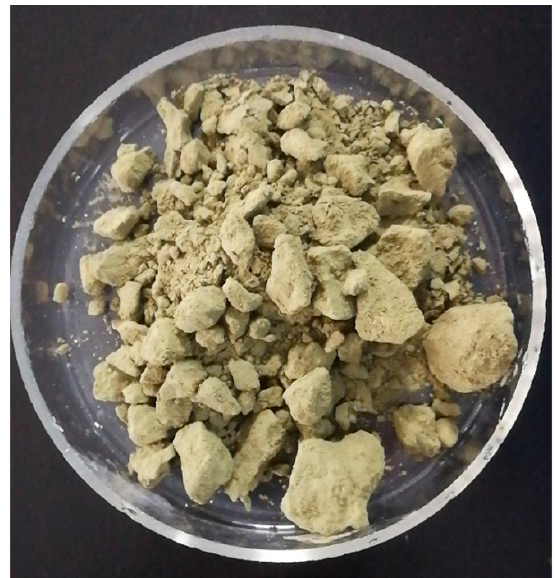
Figure 2. The image of the powder of BS mucilage extract.